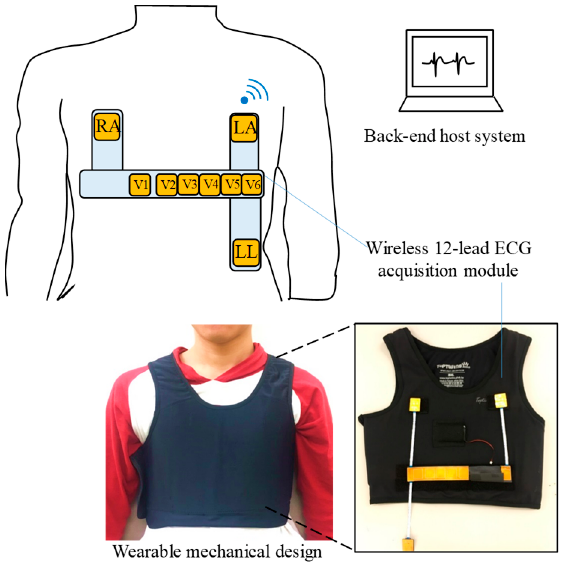
Figure 3. A basic scheme and photograph of the wearable 12-Lead electrocardiogram (ECG) monitoring system.